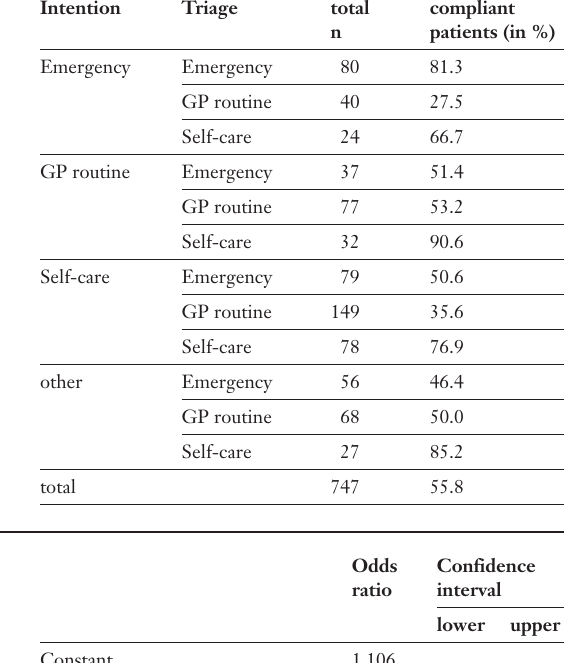
Logistic regression results predicting compliant behaviour on triage advice and intention, controlled for socio-demo- graphic patient char- acteristics (n = 748, Hosmer Lemeshow goodness of fit: Chi-square 5.534, df = 8, p =